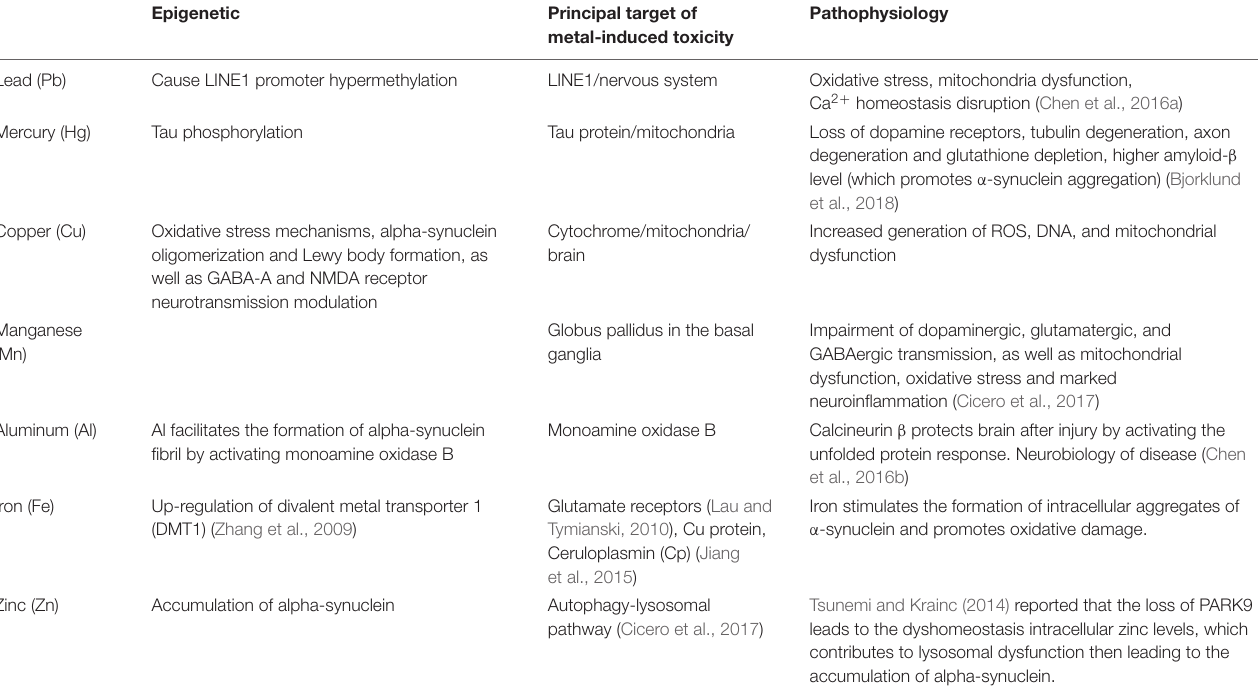
TABLE 1 | Epigenetic and toxic effects of different metals in